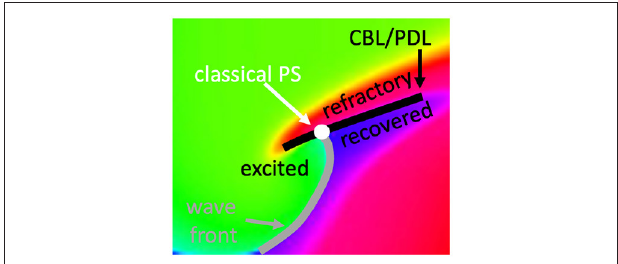
FIGURE 5 | Closer look at a linear-core rotor. At the location where classical methods detect a PS, three distinct phases come together: recovered, excited and refractory tissue. At either side of the CBL, two distinct phases are present: refractory vs. either excitable or recovered. Therefore, the CBL is a phase defect line